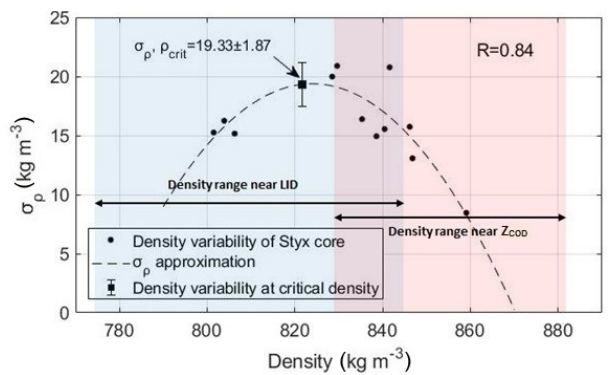
Figure 7. Density variability calculated from 1000 depth points and their average density. The standard deviation at the critical den- sity (821.68kgm − 3 ) calculated from the approximate second-order polynomial ( R = 0 . 84) is 19 . 33 ± 1 . 87kgm − 3 . The blue and red areas are the density ranges near the LID (52.38–52.48m) and the z COD (64.91–65.01m),